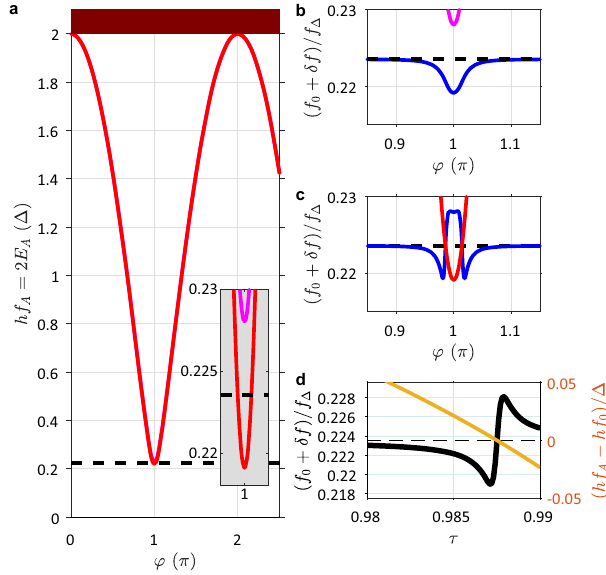
Fig. 4 Dispersive coupling of the cavity to a short channel and overview of the resulting frequency shift and detuning for different transparencies. a Pair transition energies ( hf A ) for the short junction limit for two different transparencies. Magenta and dark purple traces indicate the quasi-particle transition energy hf A for transparencies of τ = 0.987 and 0.988, respectively. b , c Cavity frequency shift δ f from the bare cavity frequency f 0 normalized by the frequency corresponding to the gap edge f Δ = Δ / h for both τ = 0.987 and 0.988, respectively. The effective coupling strength at φ = π is g eff = 0.0139 f Δ for both transparencies. As can be seen in b , when the bound states and cavity detuning remains positive the cavity frequency is dispersively shifted downward. If however the detuning is shifted through zero via the phase as in c the cavity frequency exhibits both up and down shifts. Model parameters for b and c are: ω c = 0.2235 f Δ , γ = 0.0067 f Δ , κ = 6.7 × 10 − 6 f Δ , Z = 2 × 10 − 5 . Model details can be found in the methods section. d Cavity frequency shift δ f as a function of τ at φ = π